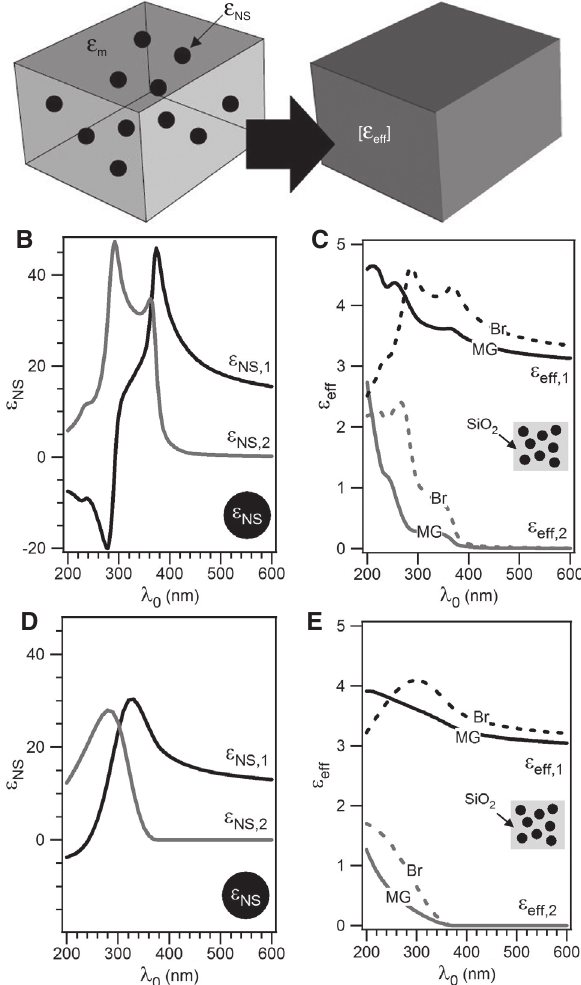
Figure 5 The effective dielectric function of assemblies of embed- ded Si NPs – model dependence. (A) Schematic representation of a nanocomposite medium and its effective equivalent. (B) Real and imaginary part of the dielectric function of Si (data taken from the Palik database), taken for the dielectric function ε (C), and (D) real and imaginary part of a dielectric function typical of some of those found in the literature for confined Si (see ref. 129), taken for the dielectric function ε Real and imaginary part of the effective dielectric function ε composite medium consisting of NPs with the dielectric function ε shown in (B) and (D), respectively, embedded in a SiO matrix. Calculations have been performed using the Maxwell-Gar- nett (MG) and Bruggeman (Br) models, assuming spherical NPs and different results both for the real and imaginary part of ε